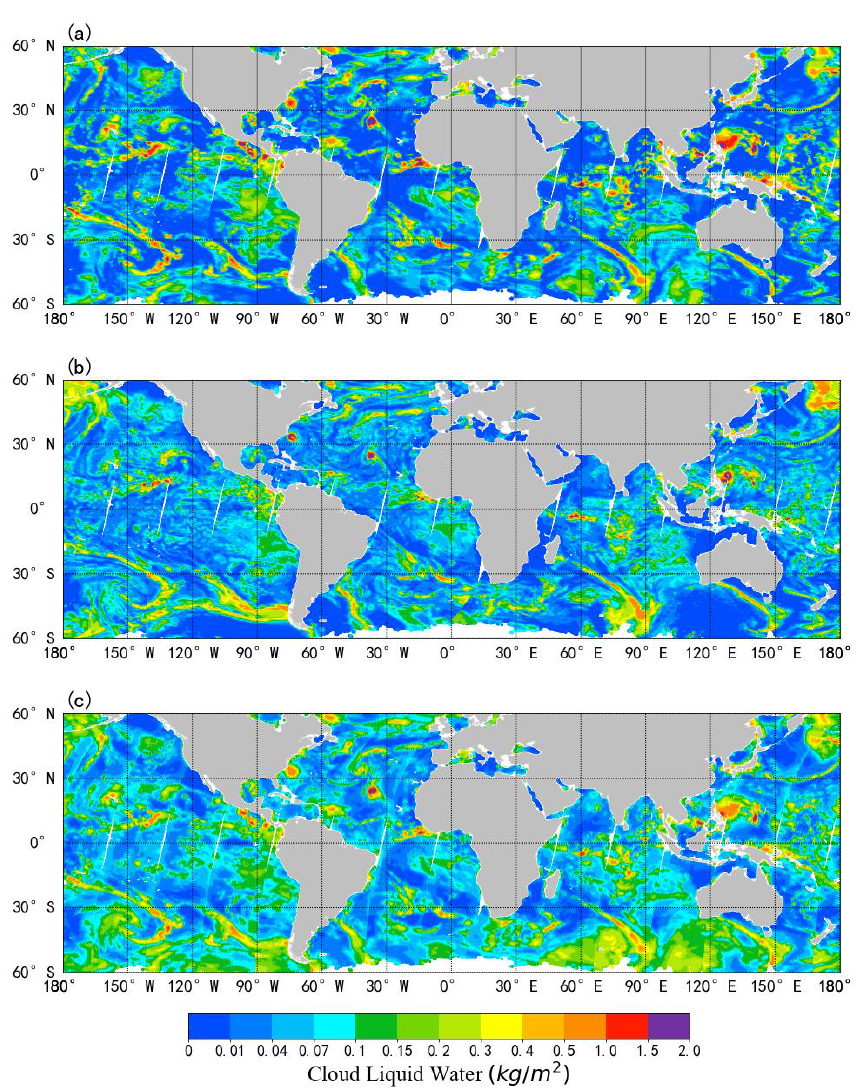
Figure 6. CLW retrieved from ATMS over global oceans on 13 September 2018 using ( a ) physical algorithm; ( b ) ERA5 reanalysis data; and ( c ) statistical algorithm.